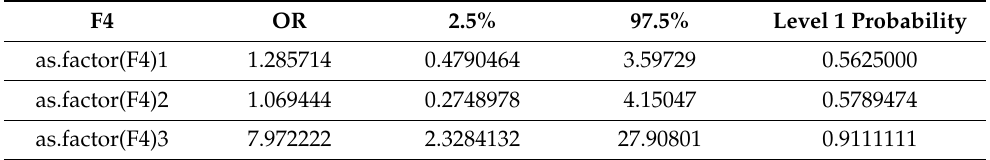
Table 2. The corresponding odds ratios and confidence intervals for the F4 parameter are shown in the table. On the right, the predicted probabilities of being in the high-level grade (level 1) are also